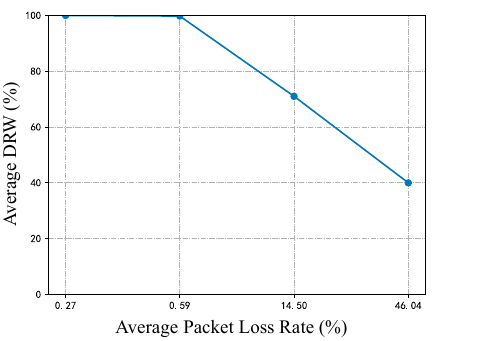
Figure 9. The DRW in different packet delays and packet loss rates.